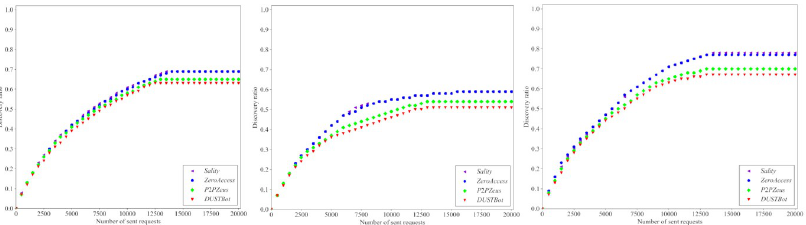
Fig 10. Performance of BFS (a), DFS (b) and LICA (c) on different anti-crawling strategies ( S